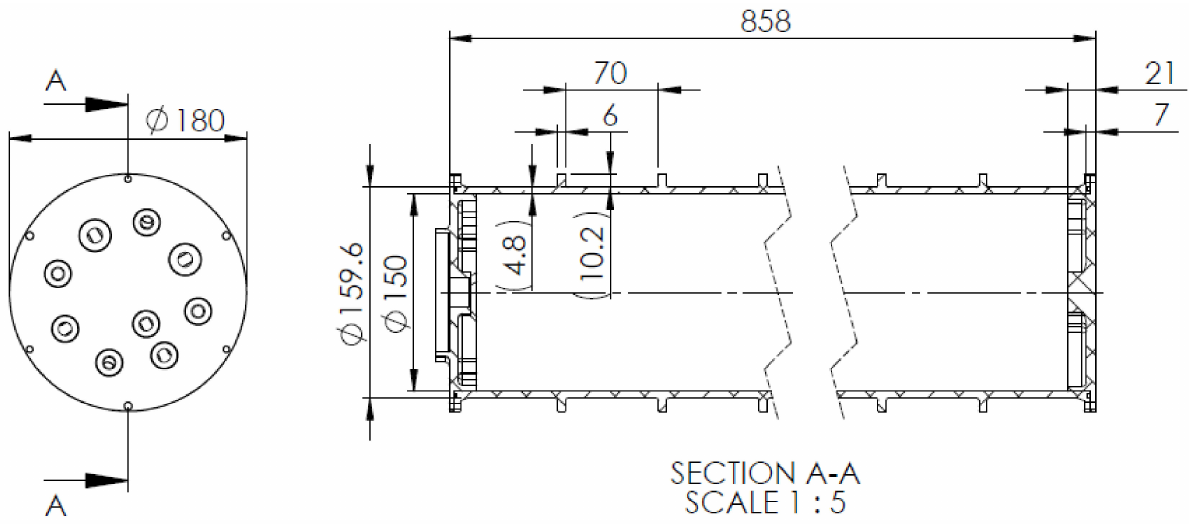
Figure 12. Float hull geometry and main